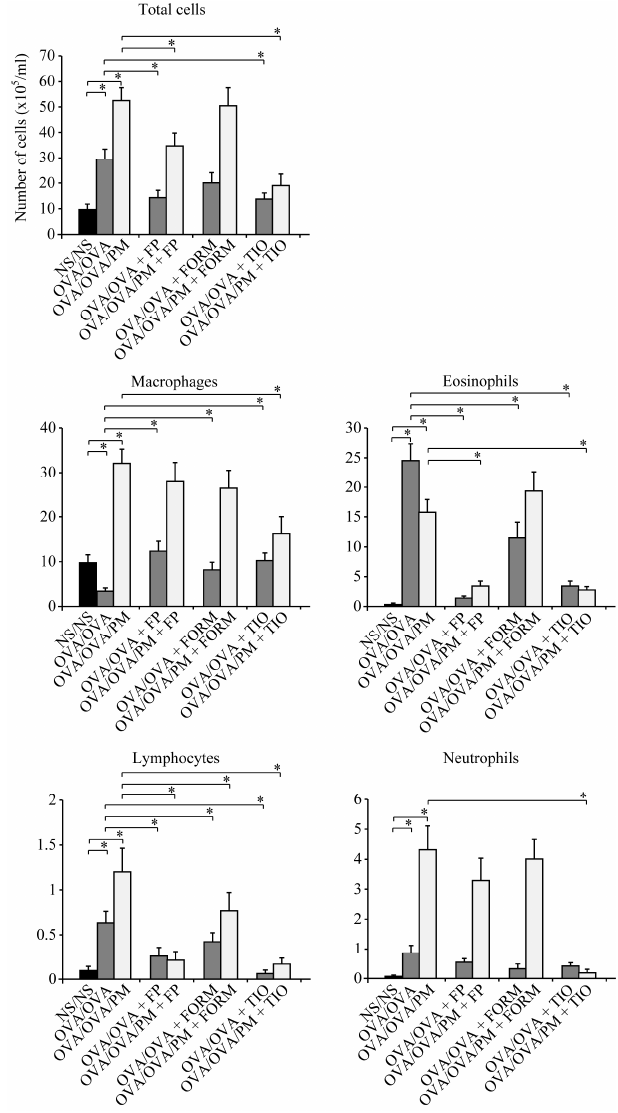
Figure 2. Total and differential leukocyte counts in bronchoalveolar lavage fluid (BALF). The cell counts in BALF were obtained 24 h after the final allergen challenge on day 26. The differential leukocyte counts included macrophages, lymphocytes, neutrophils, and eosinophils. The total cell count was significantly decreased by 35.1% in OVA/OVA/PM+FP mice and by 64.1% in OVA/OVA/PM+TIO mice, compared with OVA/OVA/PM mice. Data are expressed as the mean ± standard deviation, with eight mice per group. * p < 0.05.